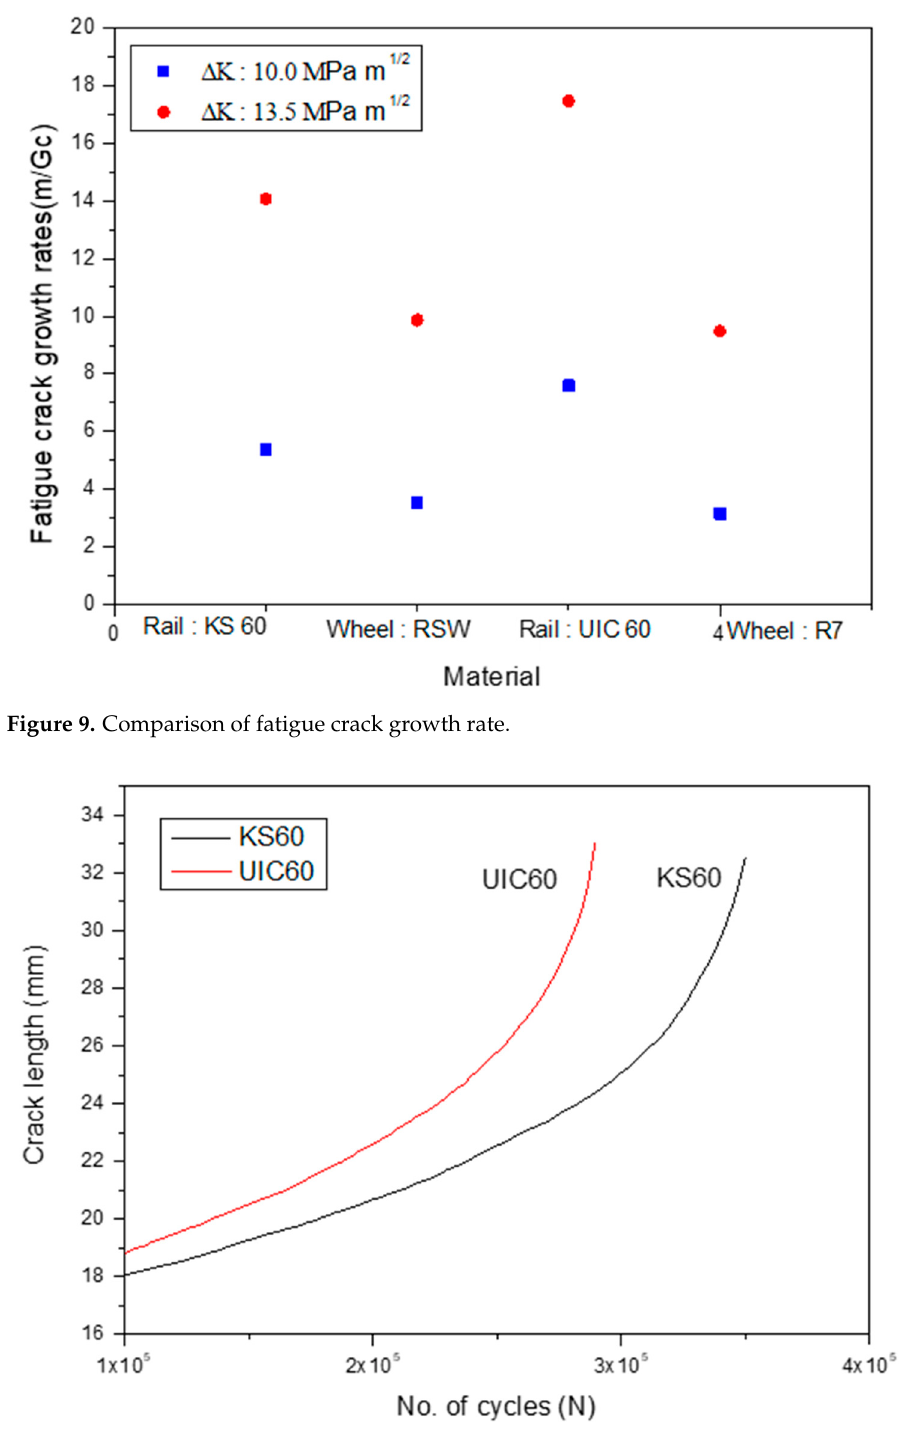
Figure 10. Cycles vs. crack length in rail steel.